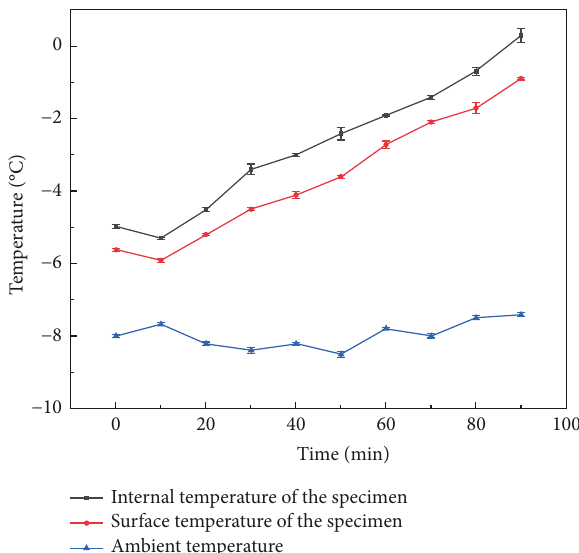
Figure 14: Heating effect of 0.4% carbon fiber +30% graphite rutting plate.